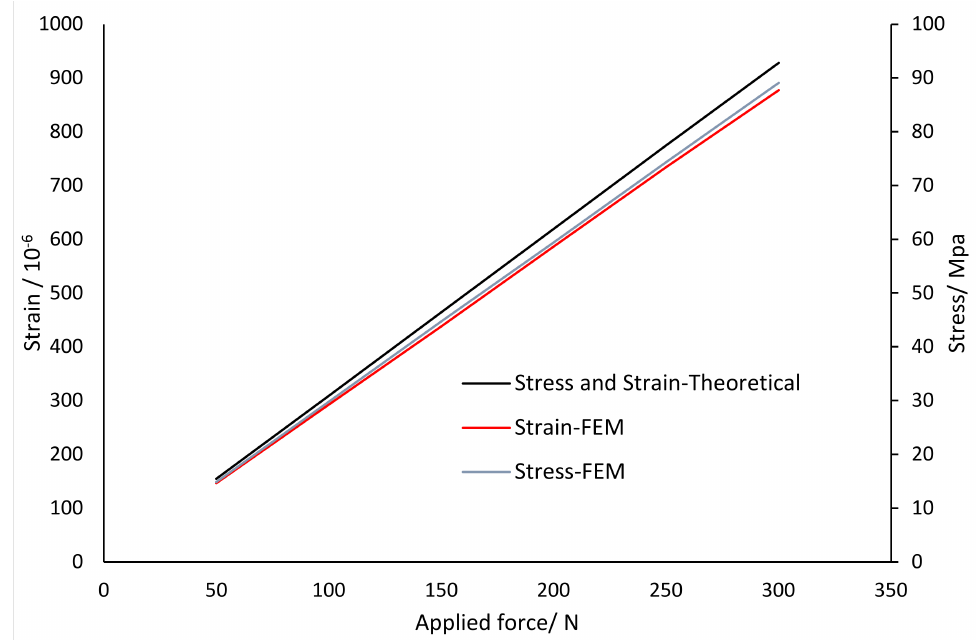
Figure 19. Stress and strain versus applied load for the theoretical and